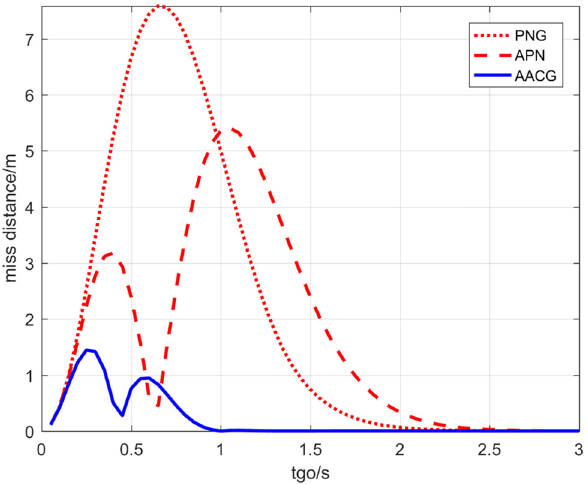
Figure 13: Target maneuver beginning t go – miss distance.